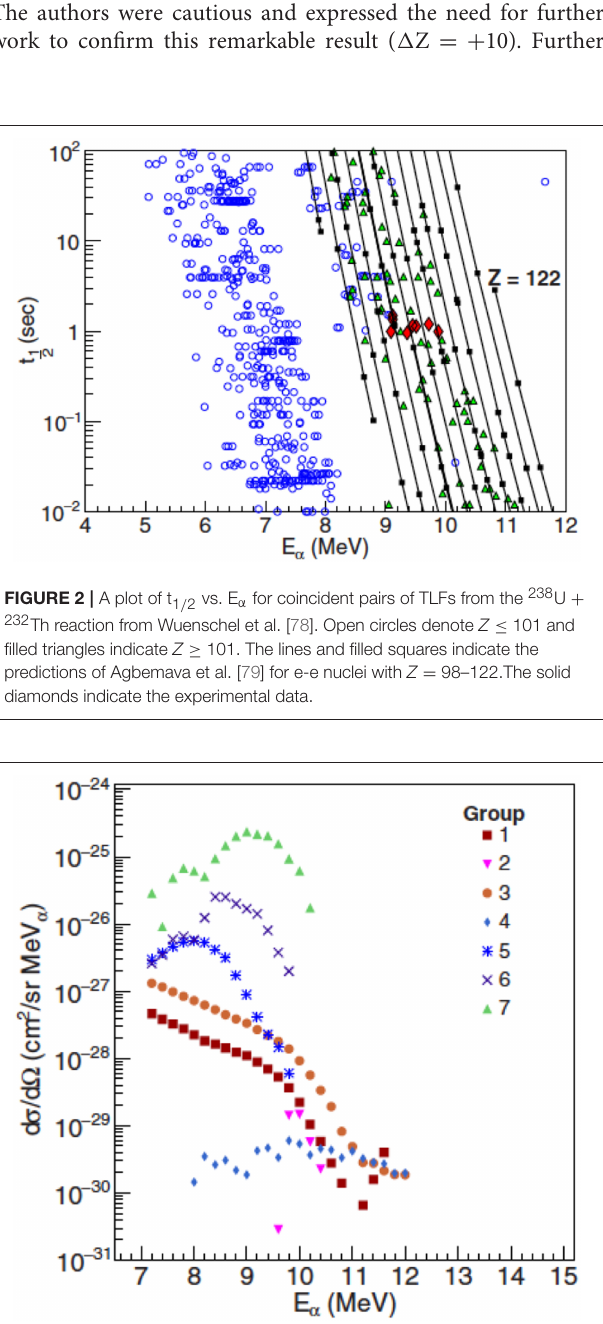
Frontiers in Physics |